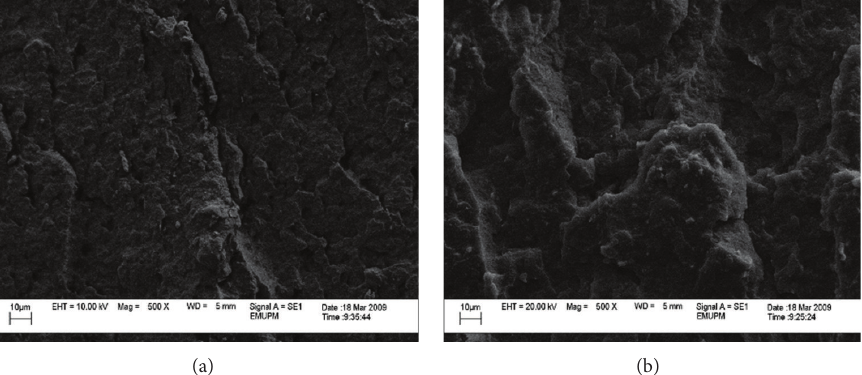
Figure 11: SEM micrograph of the fractured surface of PP/5% nano 𝛼 -Al 2 O 3 composites (a) in the presence of dispersant and (b) in the absence of